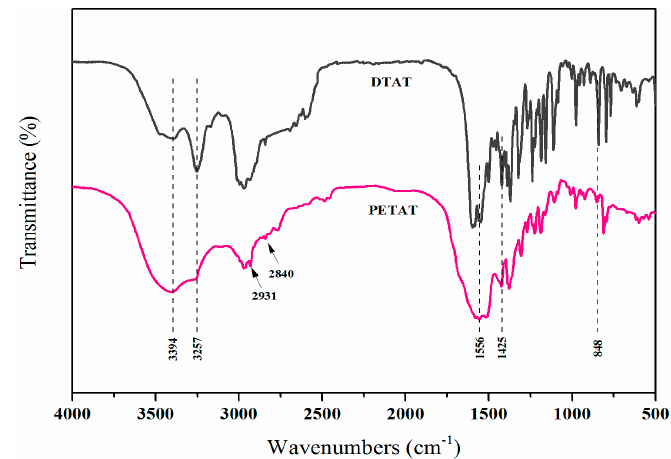
Figure 2. FTIR spectra of TAT and PETAT.